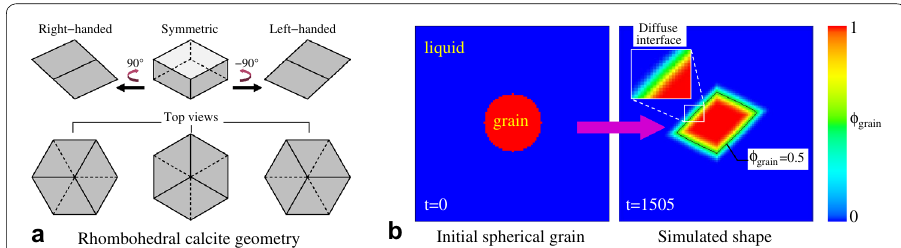
Fig. 2 a Symmetric and asymmetric projections of the rhombohedral calcite geometry. b Validation of interface energy anisotropy formulation corresponding to the asymmetric left-handed 2D projection. A spherical grain evolves to its equilibrium shape while retaining a constant volume. The final crystal shares a diffuse interface of finite width with the surrounding liquid. The shape and size of the crystal are defined by the isoline corresponding to φ grain = 0.5